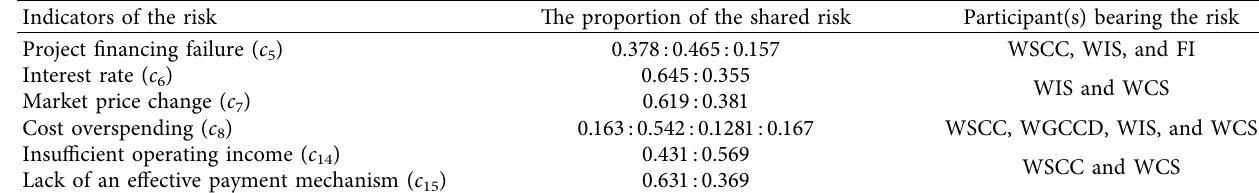
Table 7: The proportion of shared